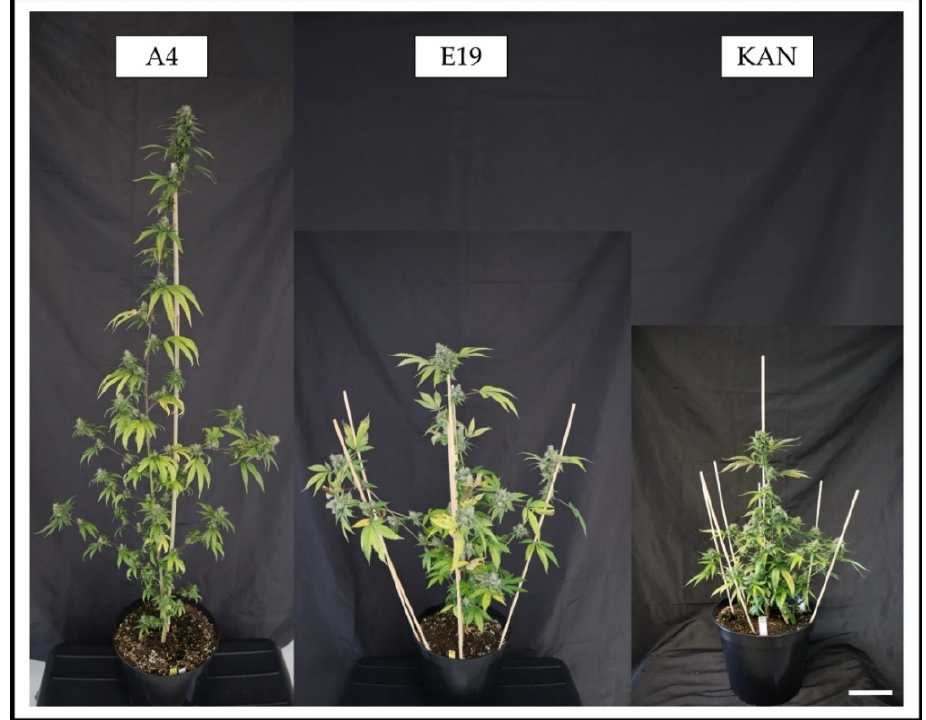
Figure 2. Exemplary plants of the strains A4, E19 and KAN at final harvest, grown under the SOL light spectra (White bar at bottom right = 10 cm).